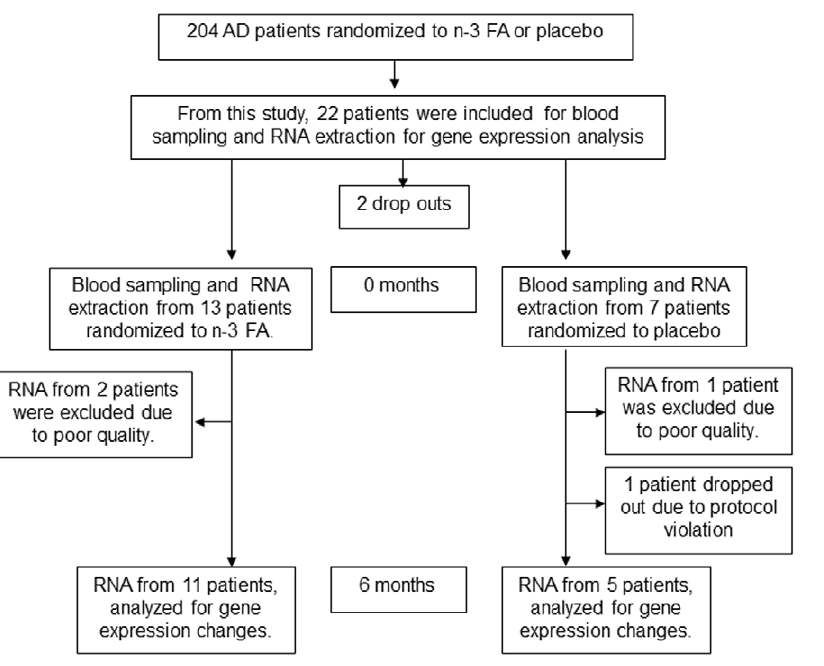
Figure 1. CONSORT flowchart. Study design at baseline and after n-3 FA or placebo supplementation to AD patients for 6 months. AD=Alzheimer’s disease, n-3 FA=Omega-3 fatty acid treatment, Placebo=Placebo treatment.